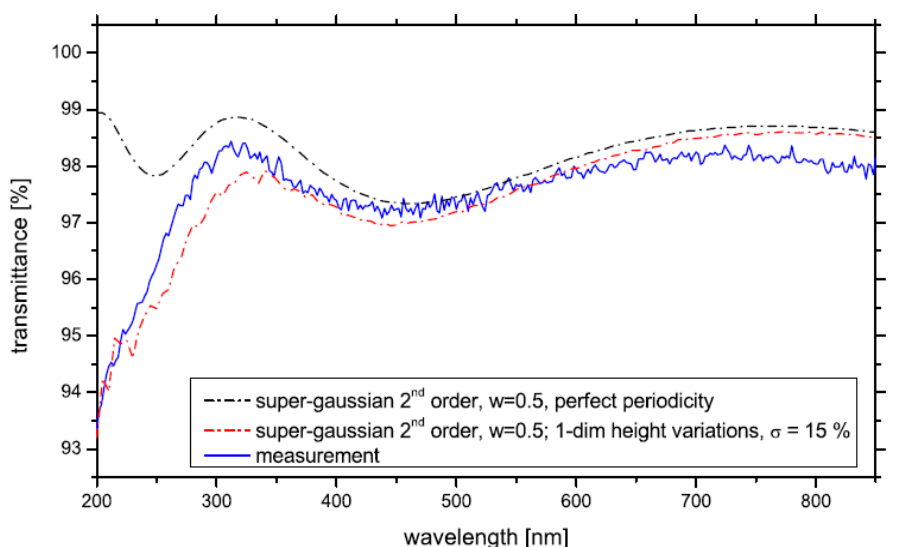
Figure 24. RCWA simulations accurately predict experimental transmission results by modeling the SWS as a super-Gaussian profile with one dimensional height variations with a standard deviation of 15%. Reprinted with permission from reference [114], Copyright 2010 Optical Society of